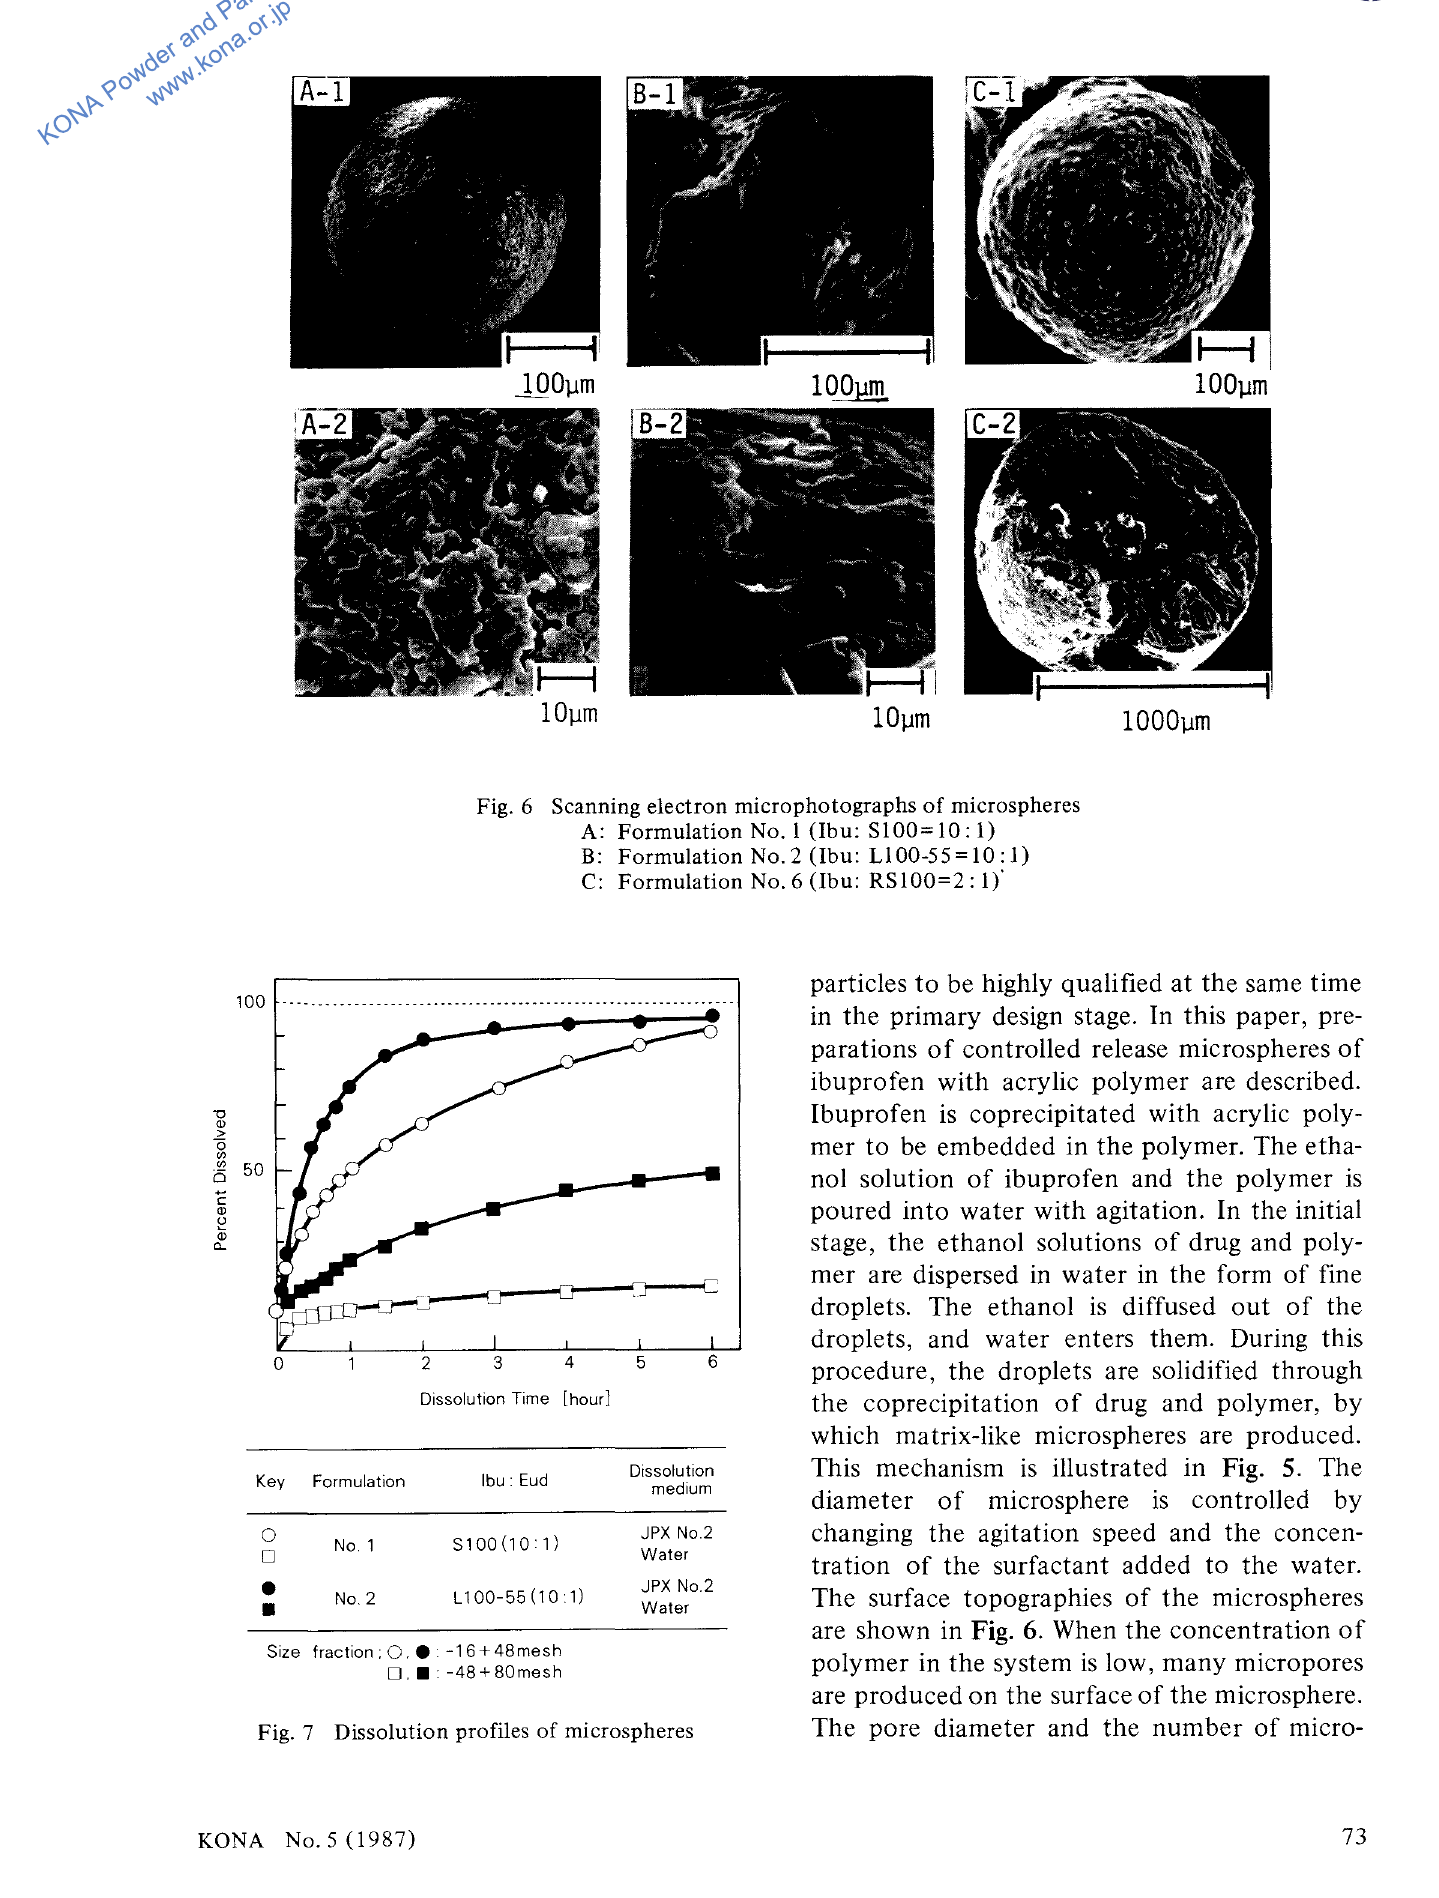
Fig. 7 Dissolution profiles of